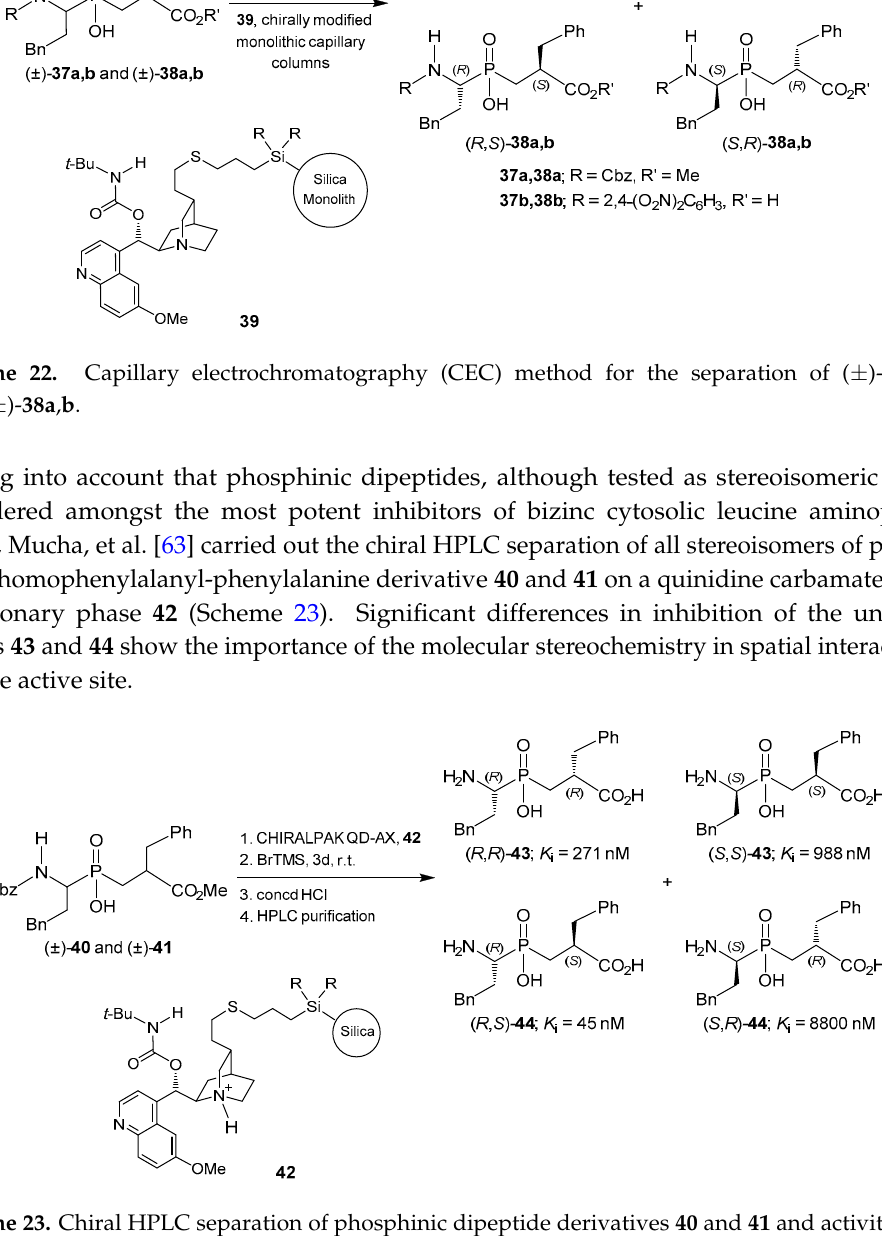
Scheme 24. Synthesis of optically pure α -aminobenzyl hydroxymethyl phosphinic acid ( R )- and ( S )- 45 . 2.5. Conversion from Chiral α -Aminophosphonates Undoubtedly, a useful but not as explored strategy for the synthesis of optically enriched α -amino- C -phosphinic acids is their conversion from the corresponding enantiomerically pure α -aminophosphonic counterparts [8]. Considering this possibility, Pyun et al. [65,66] carried out the transformation of chiral phosphonate (1 S ,2 S )- 47 into C -phosphinates (1 S ,2 S )- 50a – l . Thus, the reaction of the optically pure diethyl (1 S ,2 S )-1-amino-2-vinylcyclopropanephosphonate 47 [67] with benzyl chloroformate and NaHCO 3 followed by treatment with NaI in pyridine at reflux, gave the phosphonate monoester (1 S ,2 S )- 48 in 88% yield. The reaction of (1 S ,2 S )- 48 with oxalyl chloride and DMF in MeCN, afforded the phosphonomonochloridate (1 S ,2 S )- 49 , that without additional purification was reacted with different organolithium or Grignard reagents, to obtain the α -amino- C -phosphinates (1 S ,2 S )- 50a – d in 37%–56% yield, which have been used in the design and synthesis of new enzyme inhibitors (Scheme 25). Scheme 25. Transformation of chiral phosphonate (1 S ,2 S )- 47 into C -phosphinates (1 S ,2 S )- 50a – d .